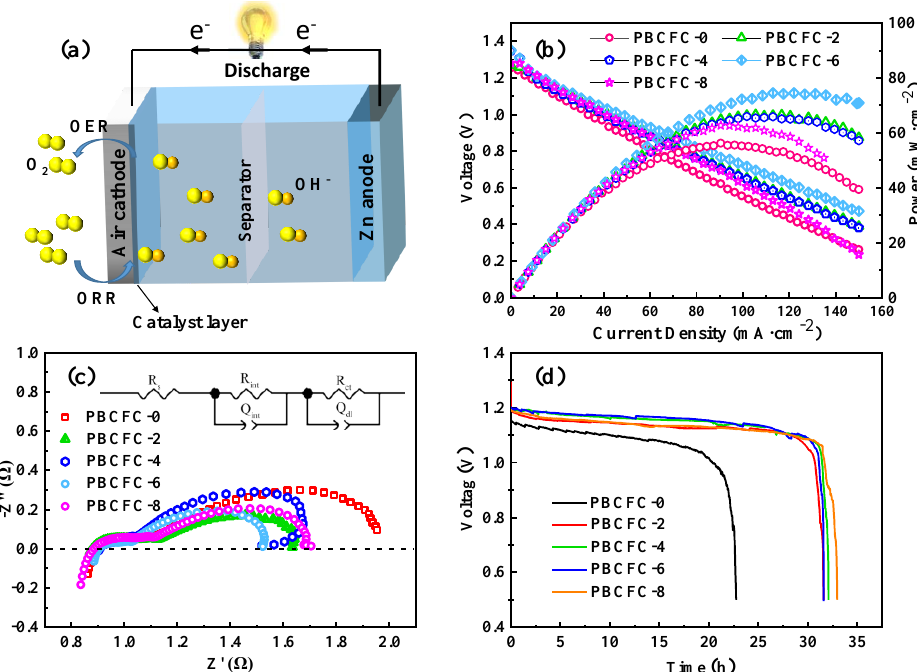
Figure 6. Diagram of the mechanism of a zinc – air battery ( a ); The power density and LSV profiles ( b ); Nyquist plots at 1 V vs. zinc ( c ); Discharge curves (10 mA·cm −2 ) ( d ) of zinc – air batteries with as the PBCFC-x (x = 0, 2, 4, 6, 8) air electrode. Table 1. The equivalent circuit components produced by the EIS values of PBCFC-x (x = 0, 2, 4, 6, 8).